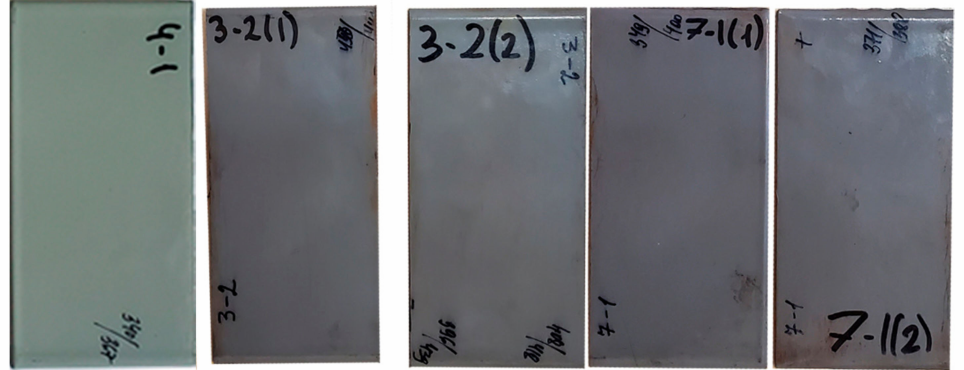
Figure 9. Samples after cyclic decompression